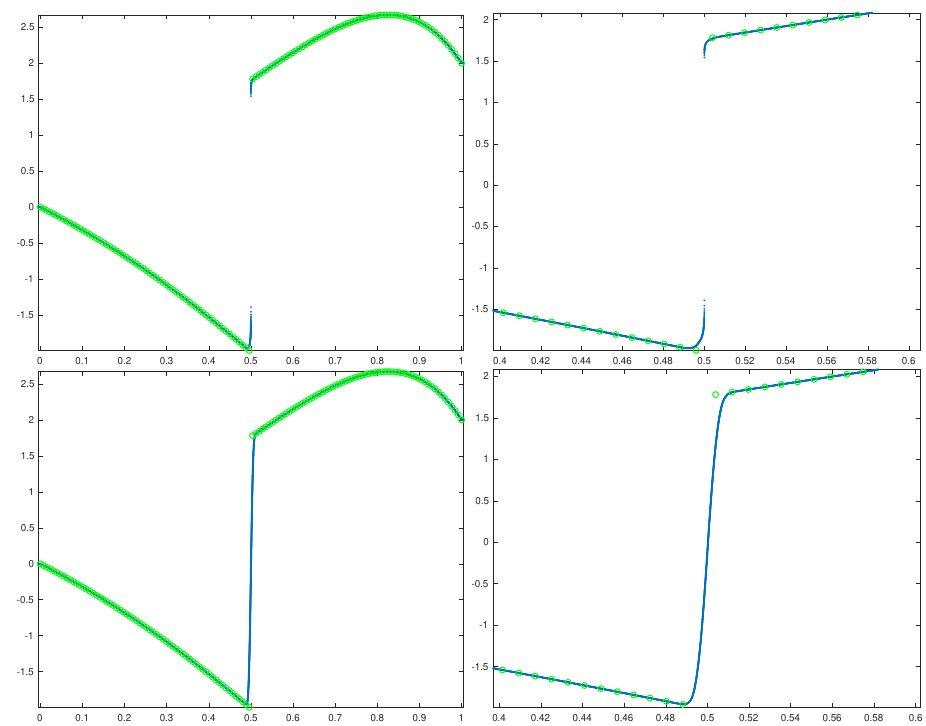
Figure 2. The results obtained for the function in (24) using 10 scales of subdivision. The top left presents the result obtained by the nonlinear version of the three points binary algorithm in (3) and (4). The plot at the top right shows a zoom around the discontinuity. At the bottom of the figure, we can observe the results obtained by the linear algorithm in (2). None of the results show Gibbs oscillations; however, the nonlinear algorithm manages to reduce the diffusion that the linear algorithm